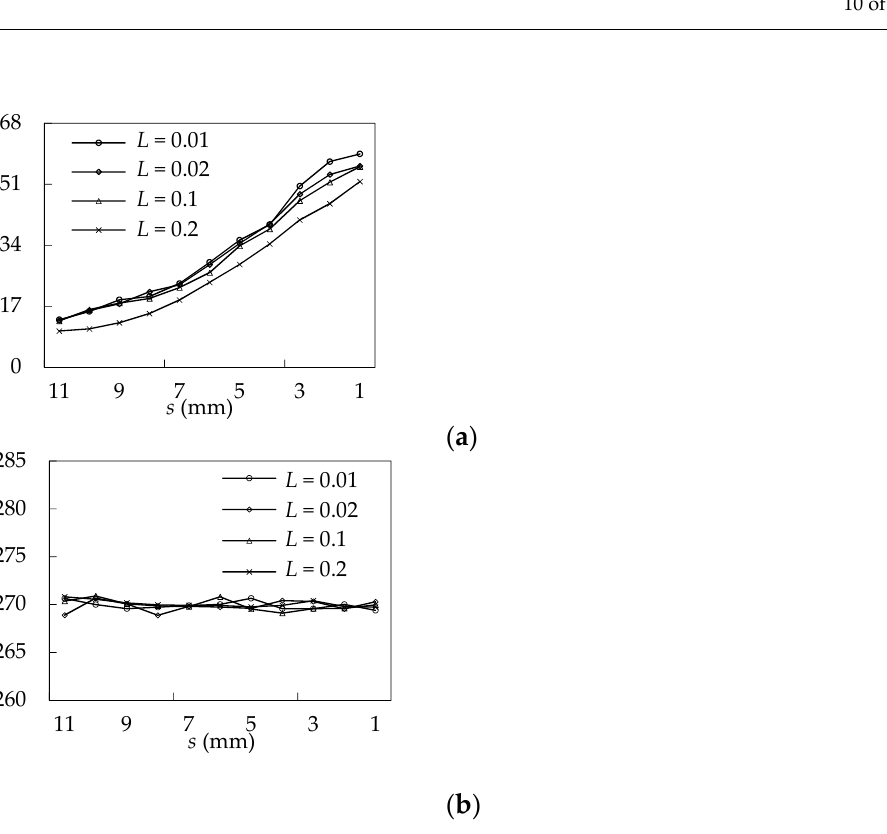
Figure 7. The electromagnetic force (EF) versus s (in the centerline of the PM slot): ( a ) the ampli- tude; ( b ) the phase